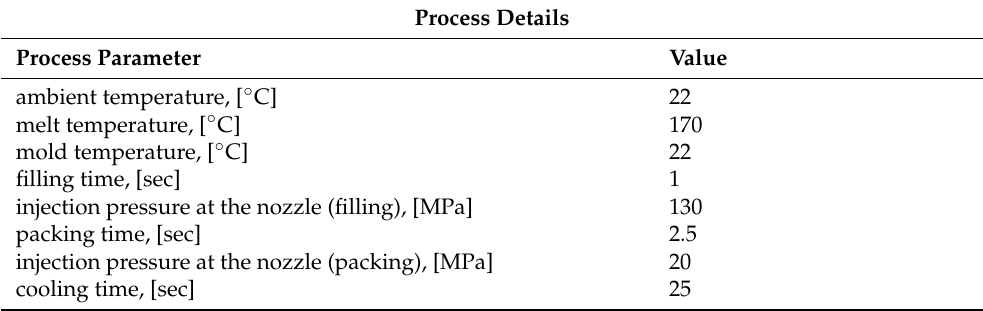
Table 4. Manufacturing